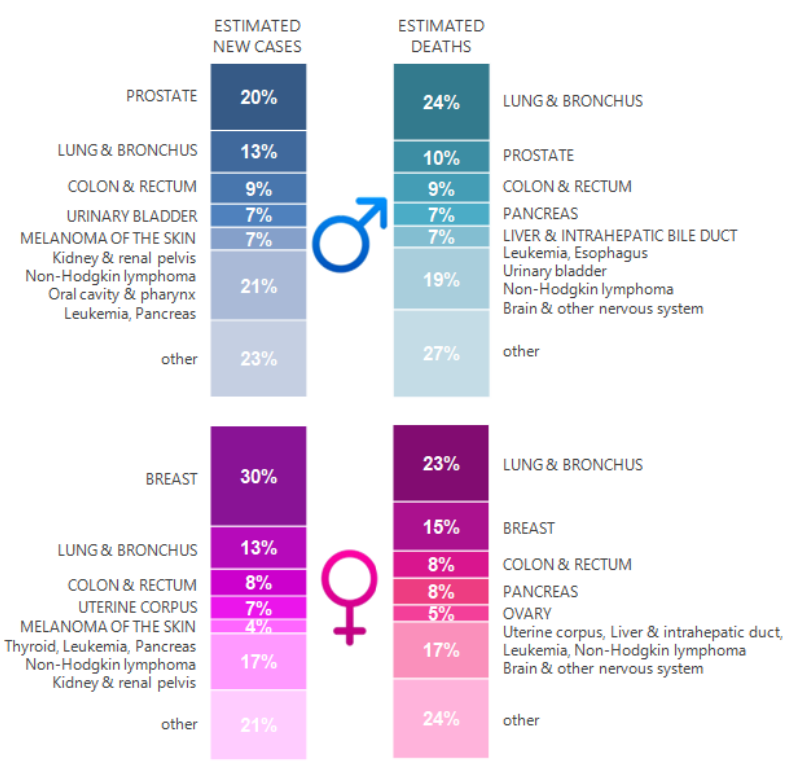
Figure 1. Lung cancer against the background of other cancer types with the highest estimated new cases and deaths by sex, United States, 2020. The estimates are rounded to the nearest 10 and exclude basal cell carcinoma, squamous cell carcinoma of the skin, and carcinoma in situ except from bladder cancer. The ranking is based on modeled forecasts and may differ from the most recent data observed (based on [8]).